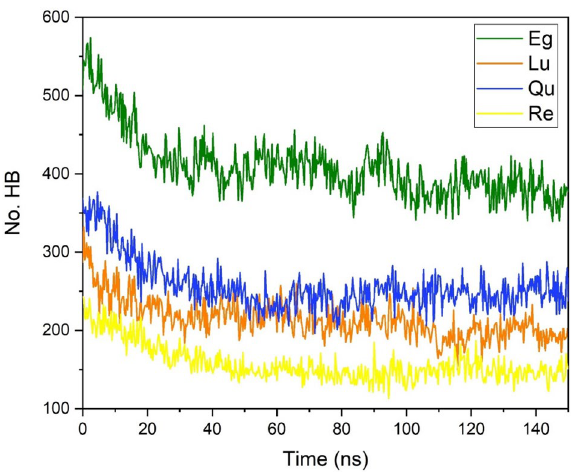
Figure 17. The number of hydrogen bonds of PP molecules with water molecules as a function of simulation time in the investigated systems.